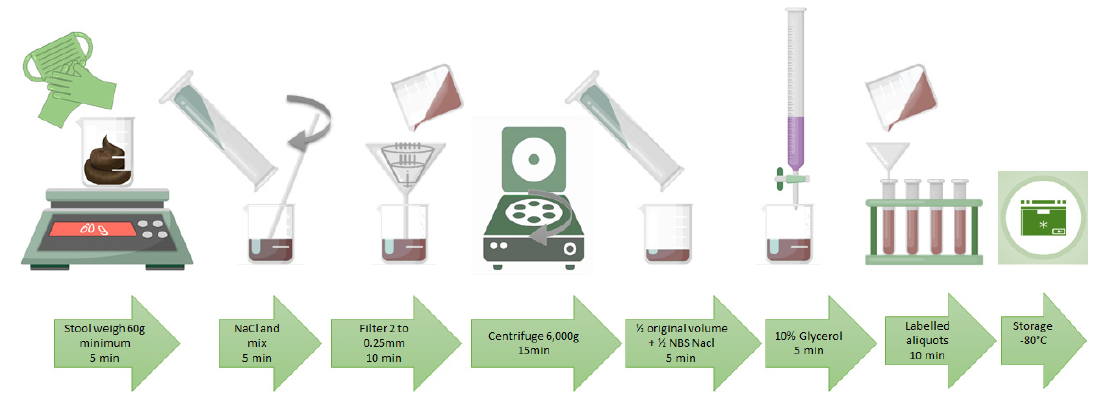
Figure 2. Schematic general steps for the preparation of fresh and frozen fecal material. Table 3. List of general steps for stool collection and the preparation of fresh and frozen fecal material. Stool Collection